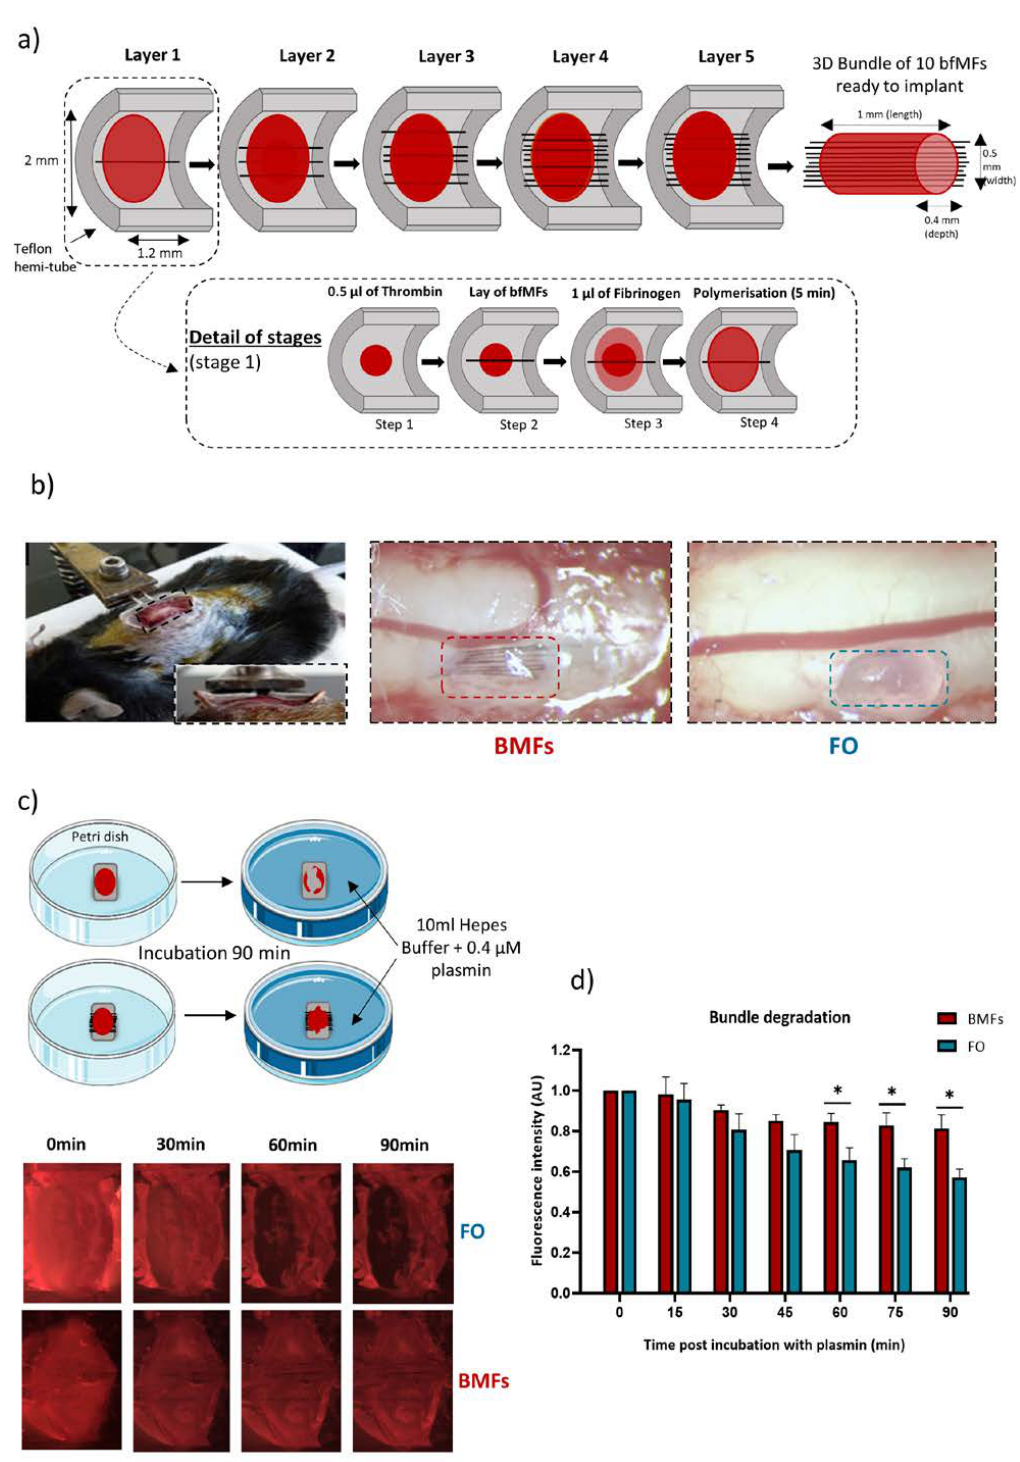
Figure 1. Preparation and characterization of the neuroprosthetic implant ( a ) Embedment of MFs in fibrin gel. The composite implant was obtained by successive layers of small volumes of fibrinogen- thrombin mixture (1:2) interspaced by biofunctionalized MFs. A teflon hemi-tube was used as support for the fabrication. ( b ) For intravital experiments, the fibrin-based implants were positioned inside the lesion cavity immediately after injury. Bright field images were taken prior to glass window placement for BMFs or FO implants. ( c ) To evaluate fibrin degradation with or without bfMFs, the implant was immersed in a bath containing 0.4 µ M of plasmin diluted in HEPES buffer. The kinetics of plasmin induced fibrinolysis was assessed by incorporating fluorescent sulforhodamine B in